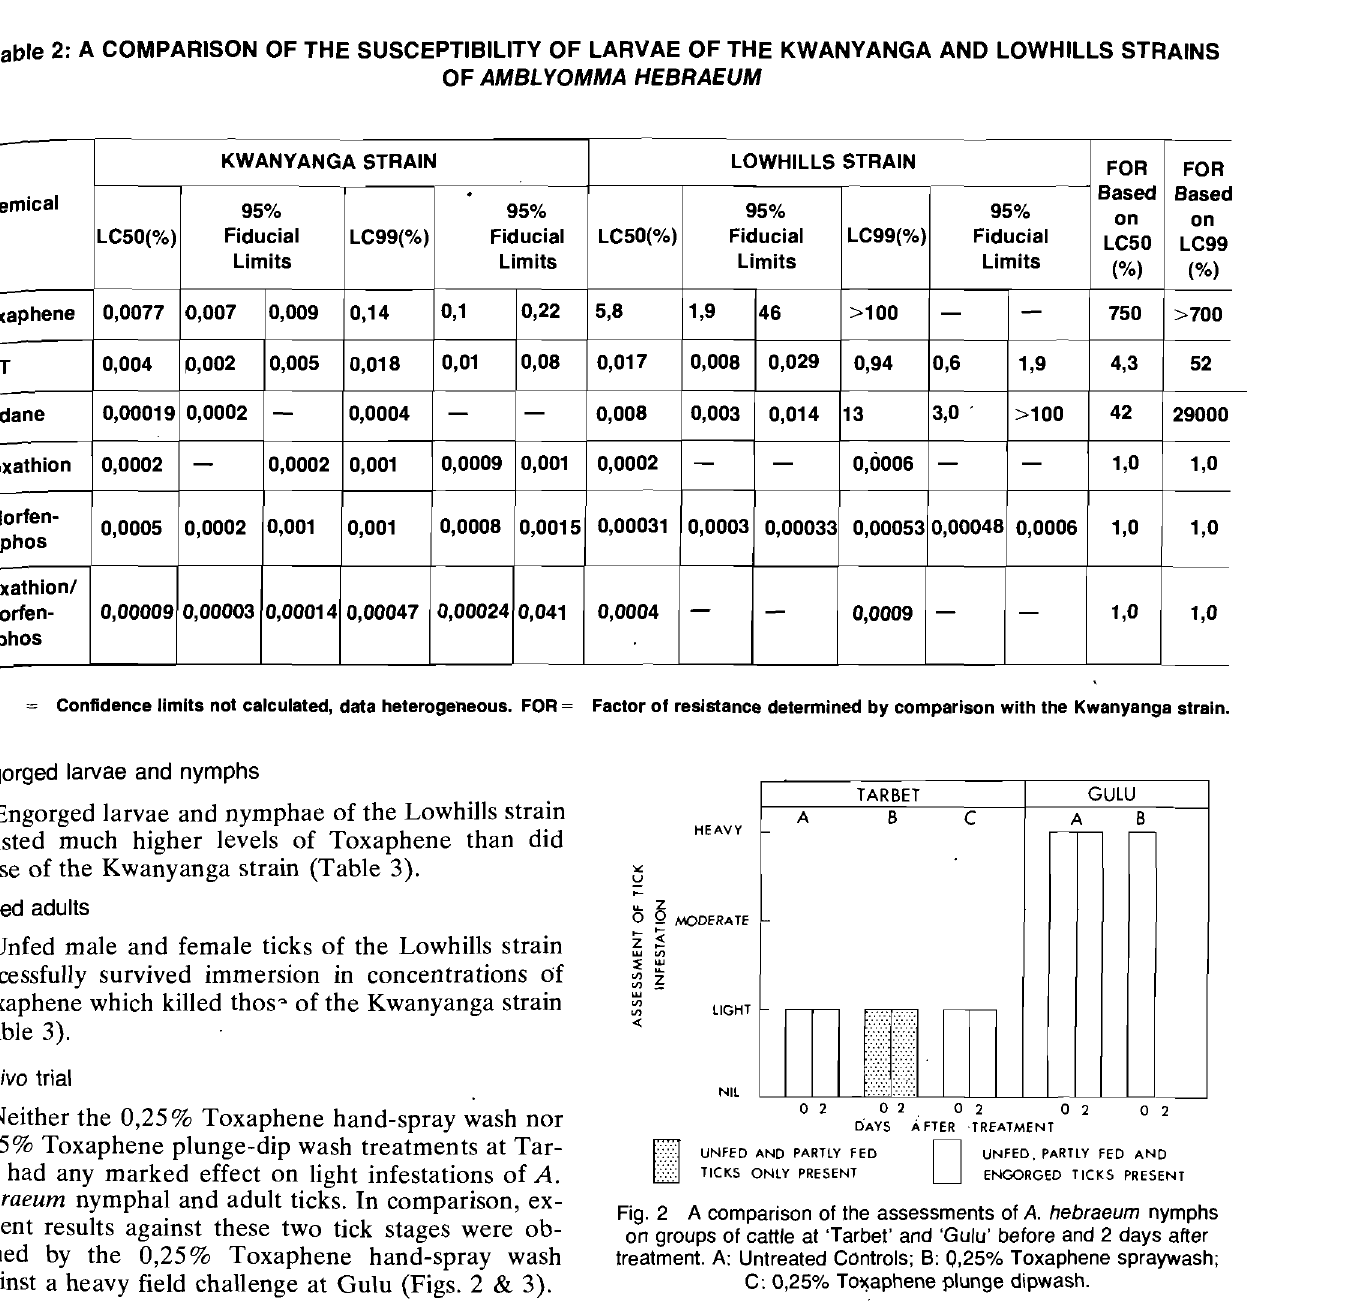
Table 2: A COMPARISON OF THE SUSCEPTIBILITY OF LARVAE OF THE KWANYANGA AND LOWHILLS STRAINS -